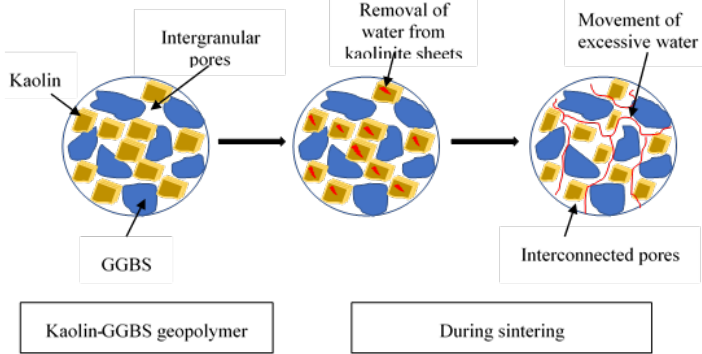
Figure 6. Illustration on the movement of water evaporation during sintering.